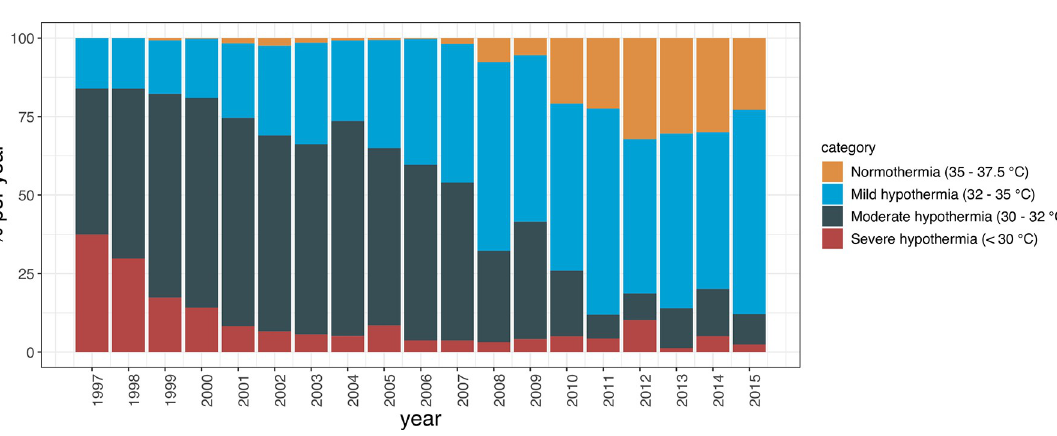
Fig 1. Trend in nasopharyngeal temperatures during CPB assisted CABG over